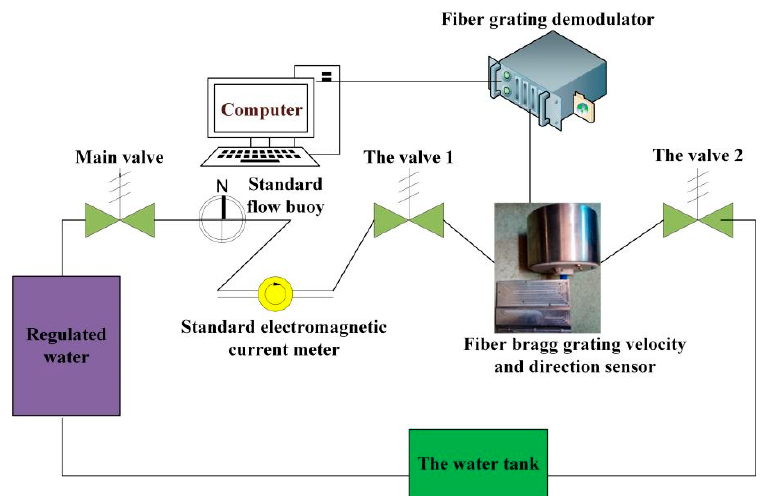
Figure 20. Experimental scheme of the sensor to monitor flow direction and velocity.